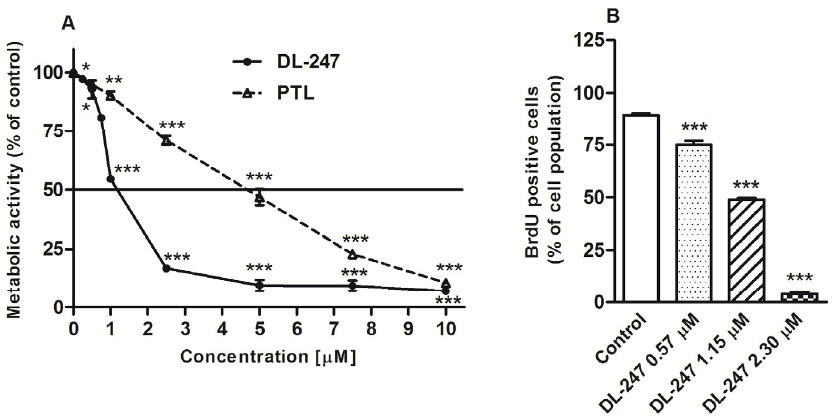
Figure 2. ( A ) Metabolic activity of HL-60 cells treated with various concentrations of 4-benzyl-5,7-dimethoxy-4-methyl-3-methylidene-3,4-dihydro-2 H -chroman-2-one (DL-247) or parthenolide (PTL) for 24 h, analyzed by MTT assay. ( B ) Incorporation of bromodeoxyuridine (BrdU) into HL-60 cells treated with increasing concentrations of DL-247 for 24 h. After treatment with tested compound, BrdU was added and cells were incubated for 8 h. Then, cells were stained with PerCP-Cy ™ 5.5 Mouse Anti-BrdU antibodies and analyzed by flow cytometry. ( A , B ): Data are presented as mean ± SEM of three independent experiments. Statistical significance was assessed using one-way ANOVA and a post-hoc multiple comparison Student–Newman–Keuls test. * p < 0.05, ** p < 0.01, *** p < 0.001, vs. control. Table 1. Cytotoxic activity of DL-247 and PTL on HL-60 cell line and normal HUVEC cells.